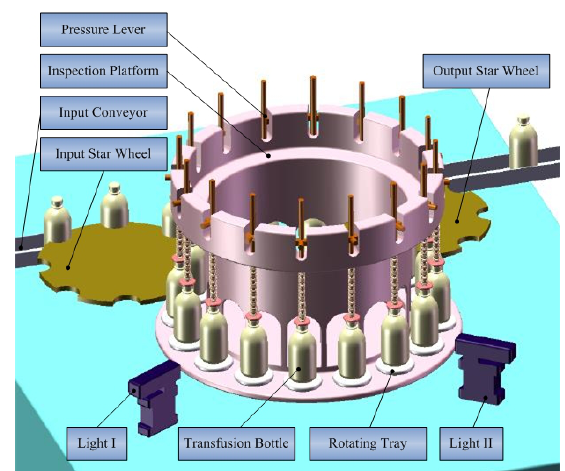
Figure 4. Three-dimensional drawing of the Automatic Inspection